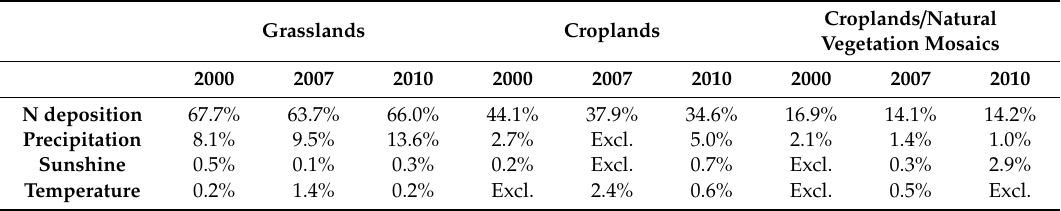
Table 3. Coe ffi cient of determination (R 2 ) change per variable (alphabetically ordered) that the stepwise regression model selected for grasslands, croplands, and croplands / natural vegetation mosaics. Excl: Excluded. Natural logarithms of N deposition used for grasslands in all the years and for croplands in 2000.